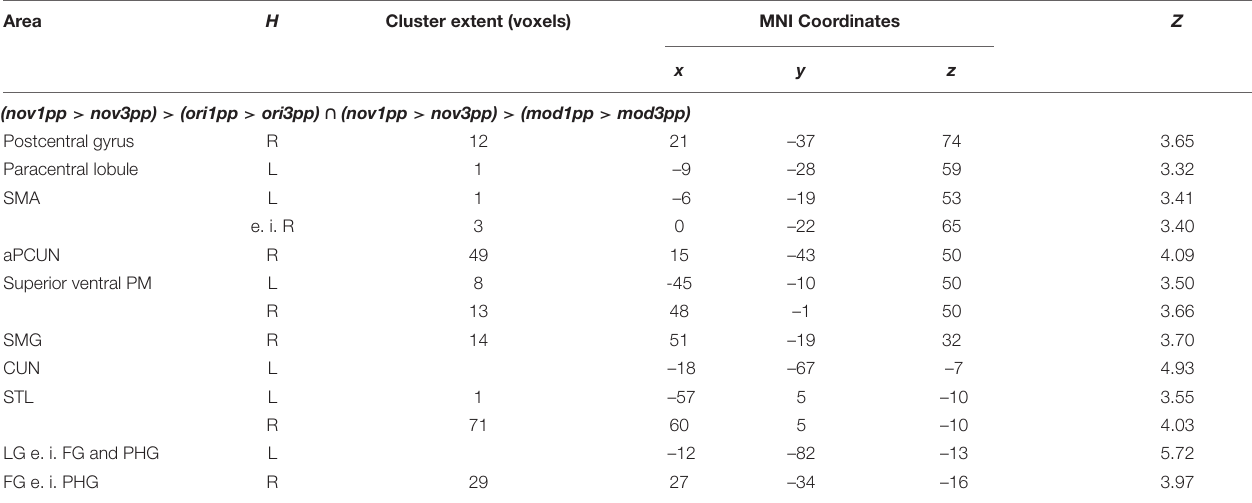
TABLE 3 | Peak activations from second-level whole-brain analyses of perspective